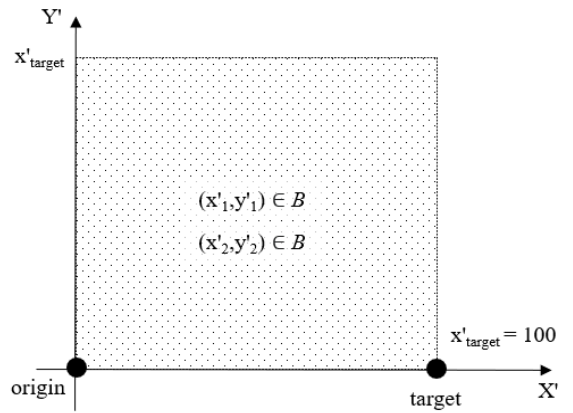
Figure 7. Range of the uniformly distributed baseline training data. The baseline data covers the entire problem space. Compared to Figure 6, the X (cid:48) -axis is translated to the right by ( x (cid:48) target